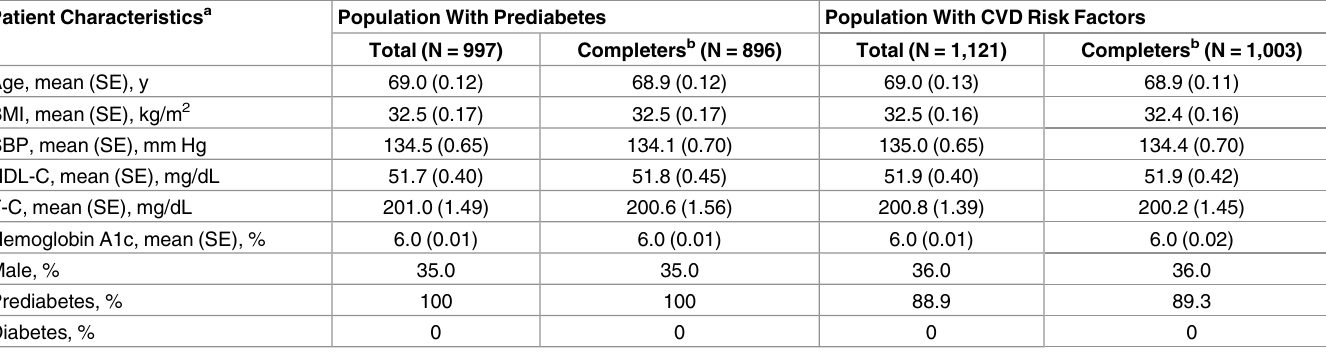
Table 1. Characteristics of Population with Prediabetes and Population at risk for Cardiovascular Disease at Baseline. Patient Characteristics